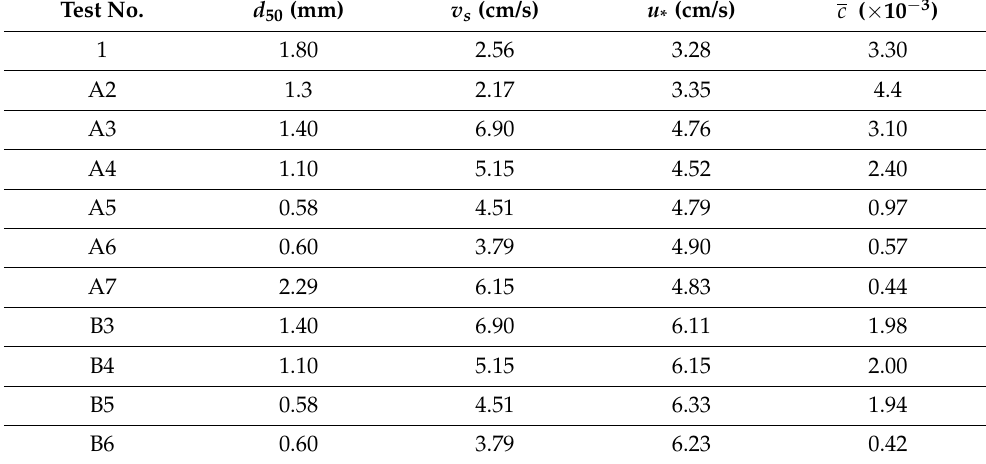
Table 3. Data by Wang and Ni